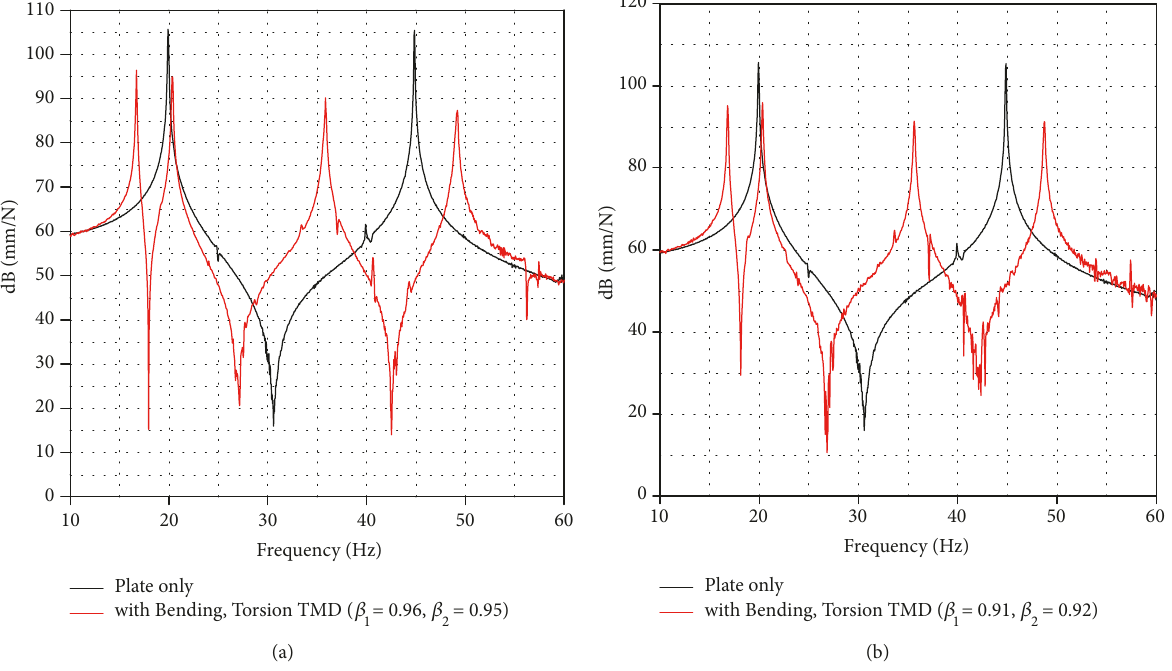
Figure 13: Experimental FRF results of the primary structure with TMDs: (a) with the TMDs tuned individually and (b) with the optimized TMDs (Key: black line, Primary: red line,